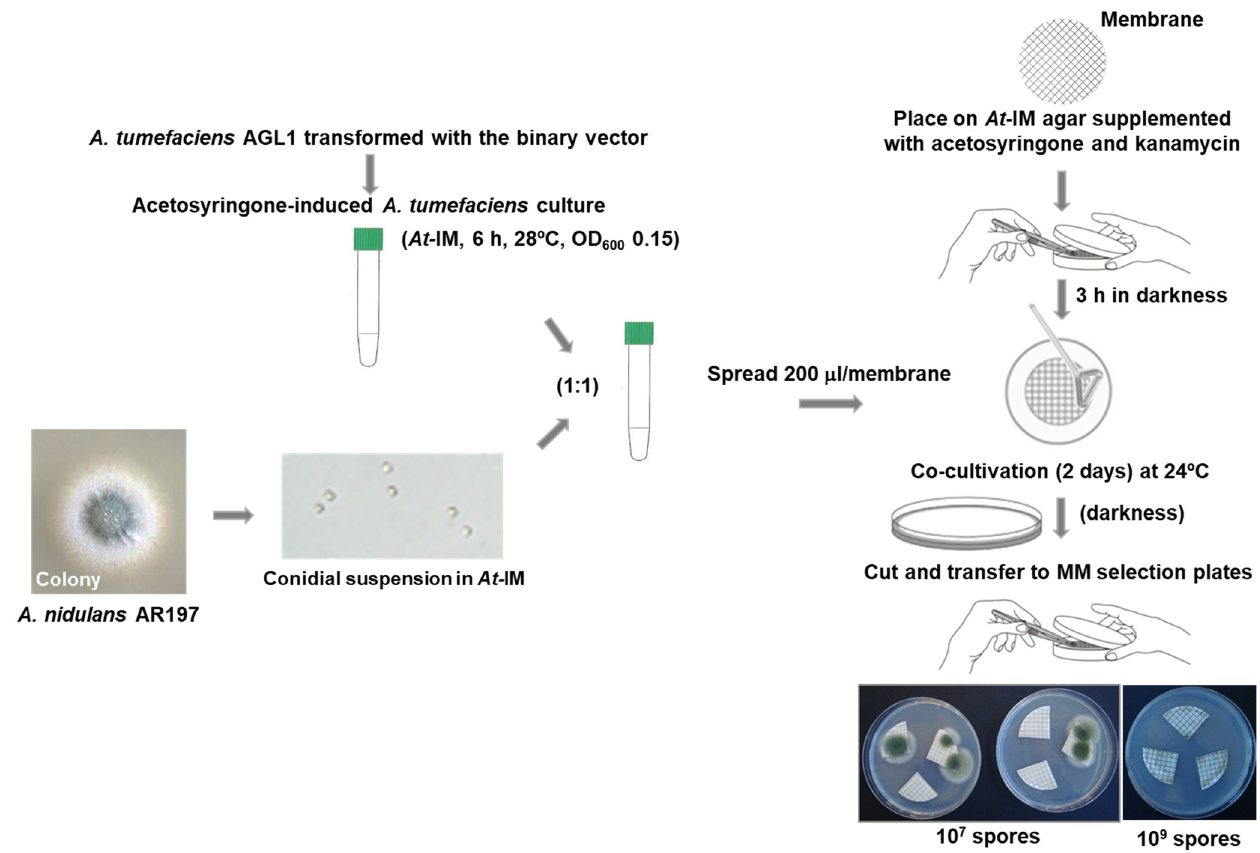
Figure 2. Schematic overview of ATMT of A. nidulans conidia. Transformants were obtained after 3 days’ growth at 37 °C on Aspergillus selective MM plates supplemented with cefotaxime. At -IM: induction medium supplemented with kanamycin and acetosyringone.